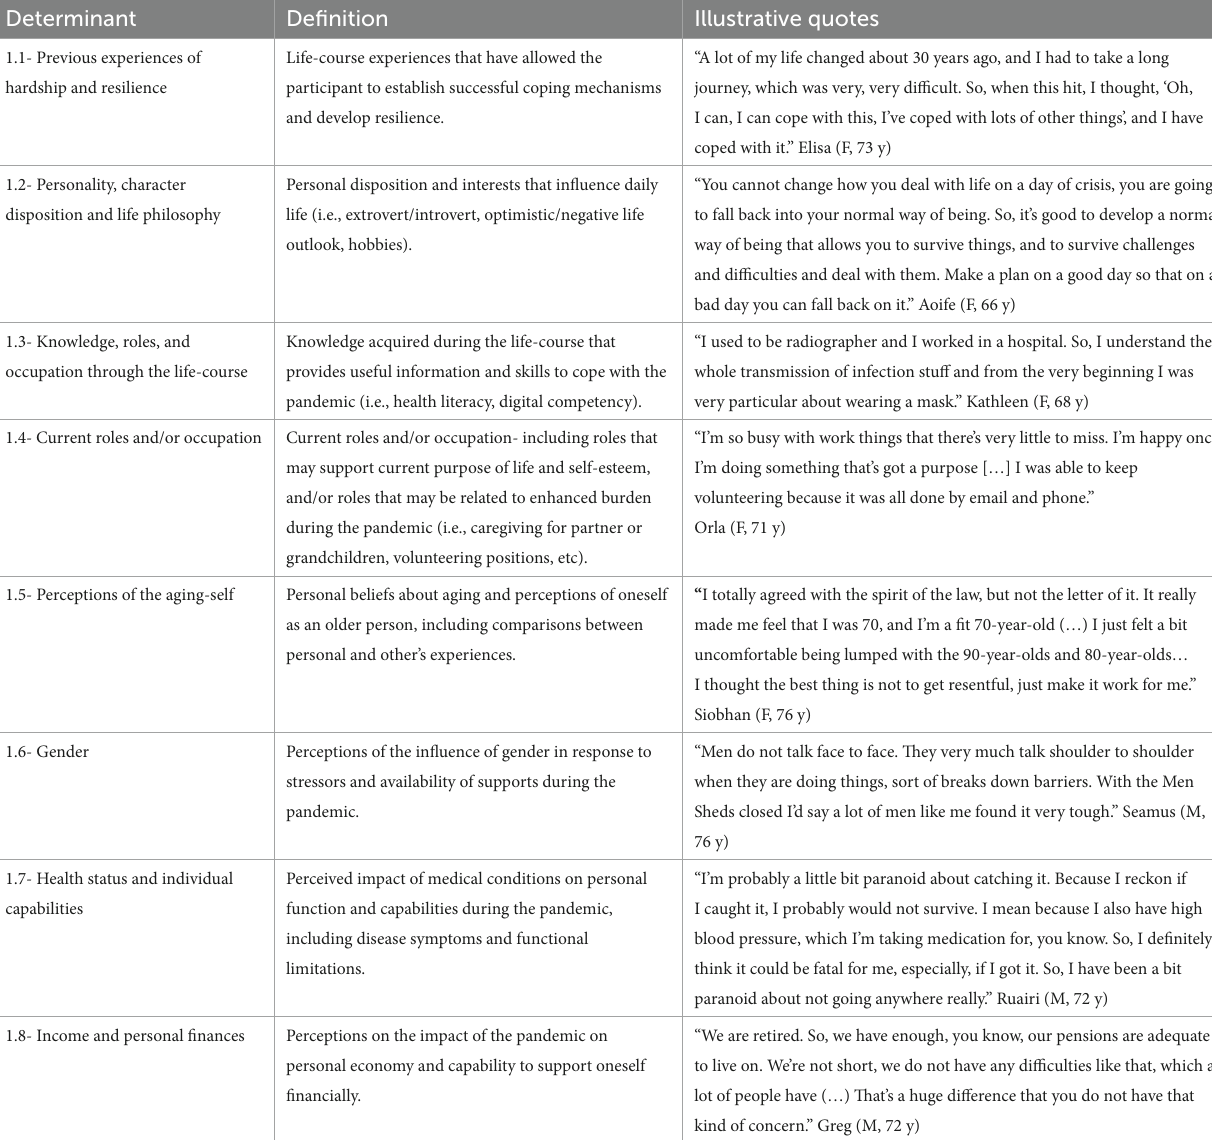
TABLE 2 Details of socio-ecological determinants at the individual level (L1).